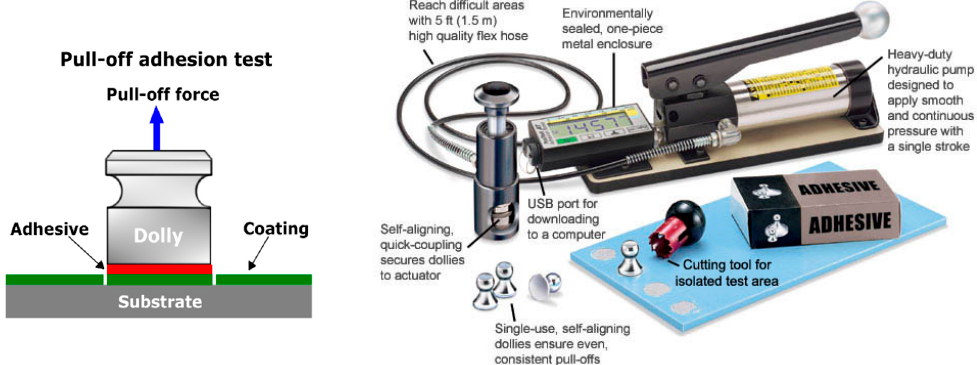
Figure 4. Pull-off adhesion test and required instrument kit Figure 4. pull-off adhesion test and required instrument kit [64,65].